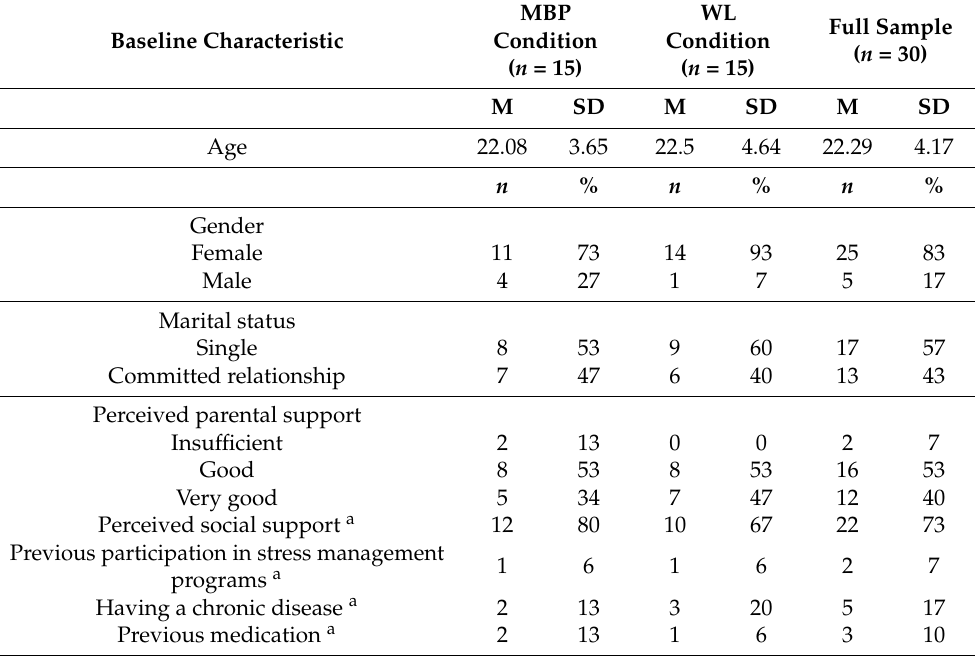
Table 1. Characteristics of study